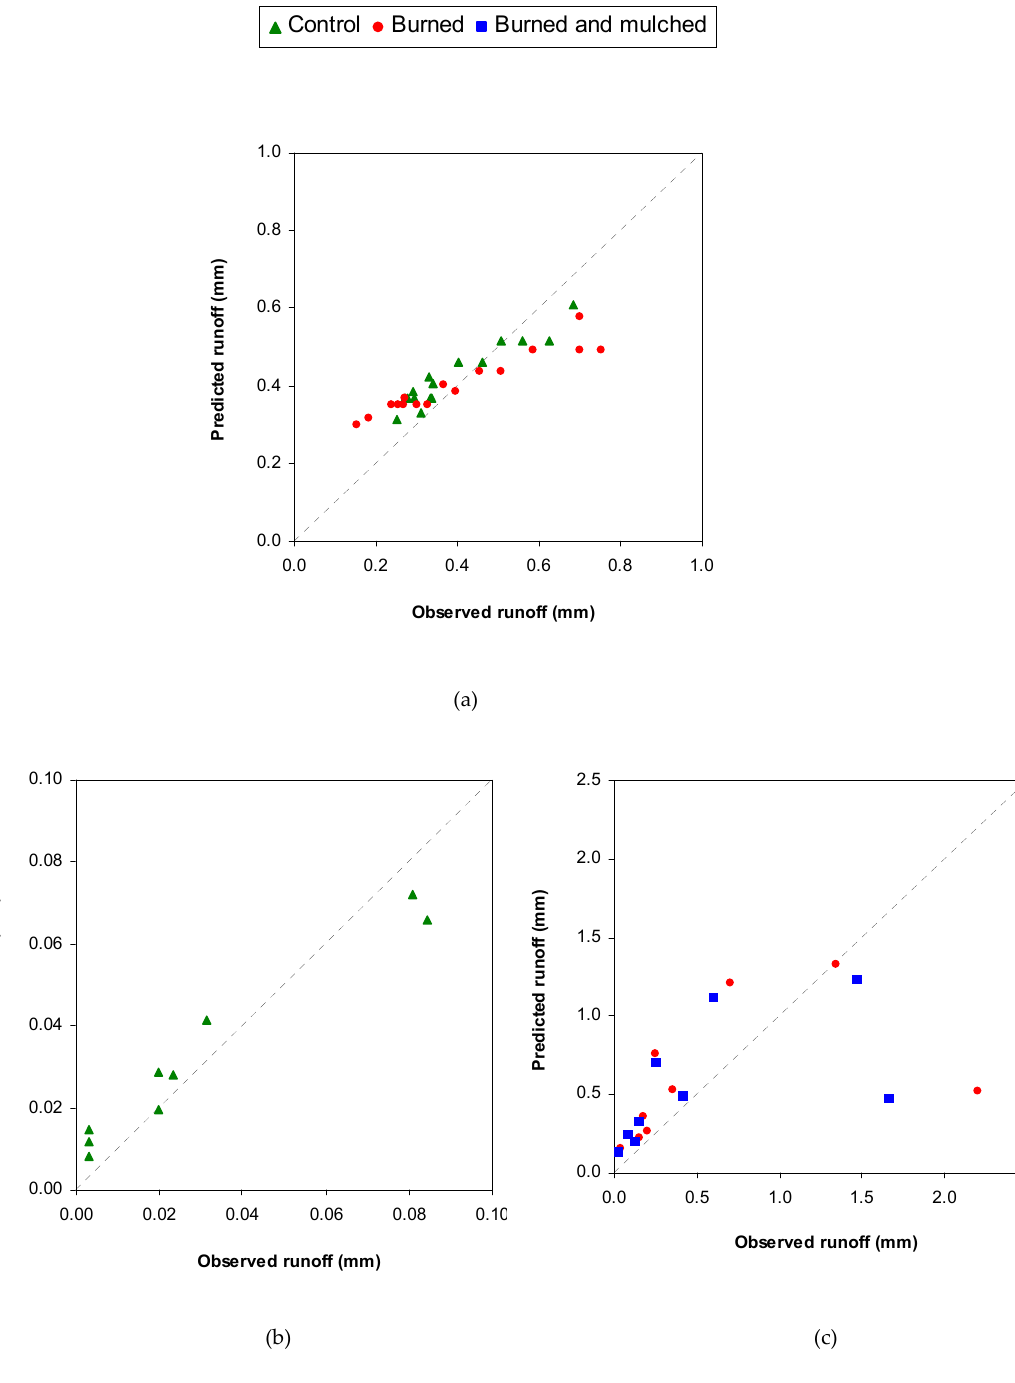
Figure 5. Scatterplots of runoff observations vs. predictions using linear regressions in plots subject to prescribed fire (Lezuza, a ) and wildfire (Liétor, control soils, b , and burned soils c ) (Castilla La Mancha, Spain).